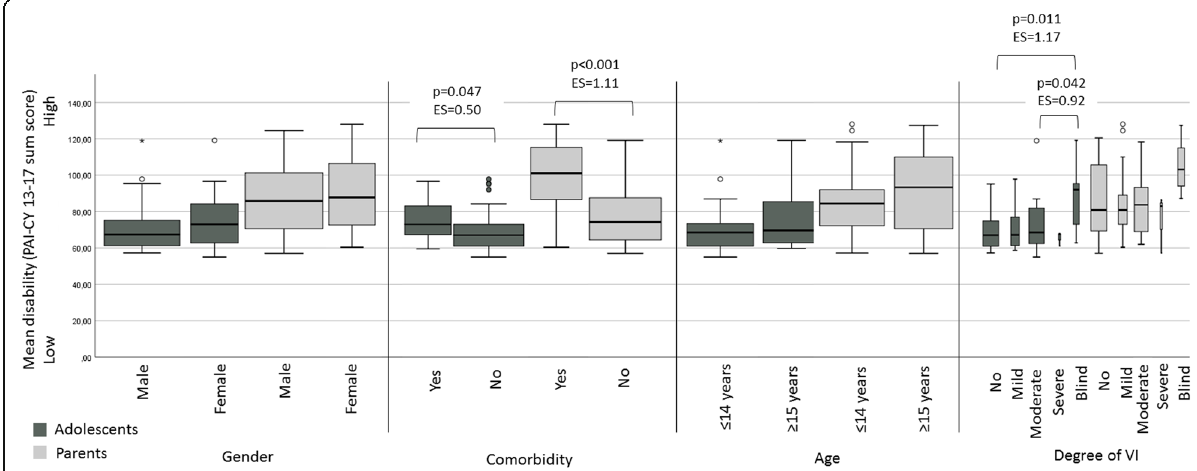
Fig. 2 Boxplots for groups that differ on gender, comorbidity, age and degree of VI. Box width represents group sizes. ES: effect size; VI: visual